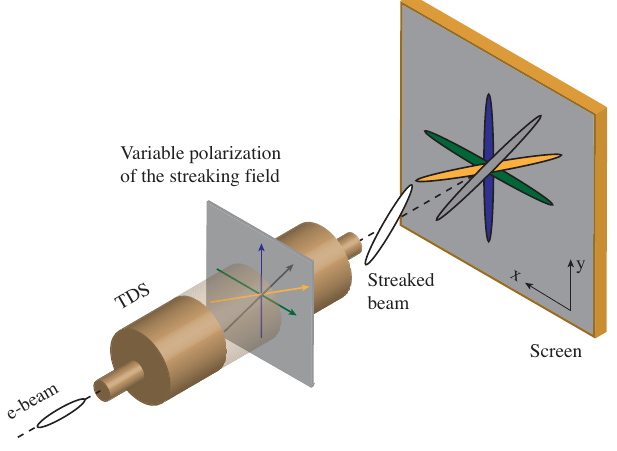
FIG. 1. Schematic of a longitudinal diagnostic system based on the variable polarization of the PolariX